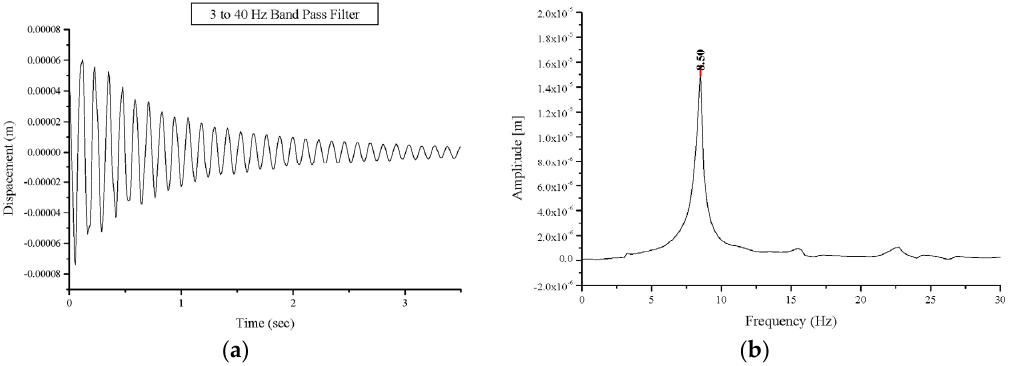
Figure 11. Free oscillations’ response of the strengthened vault BV3: ( a ) displacement versus time; ( b ) Fourier transform: amplitude versus frequency.